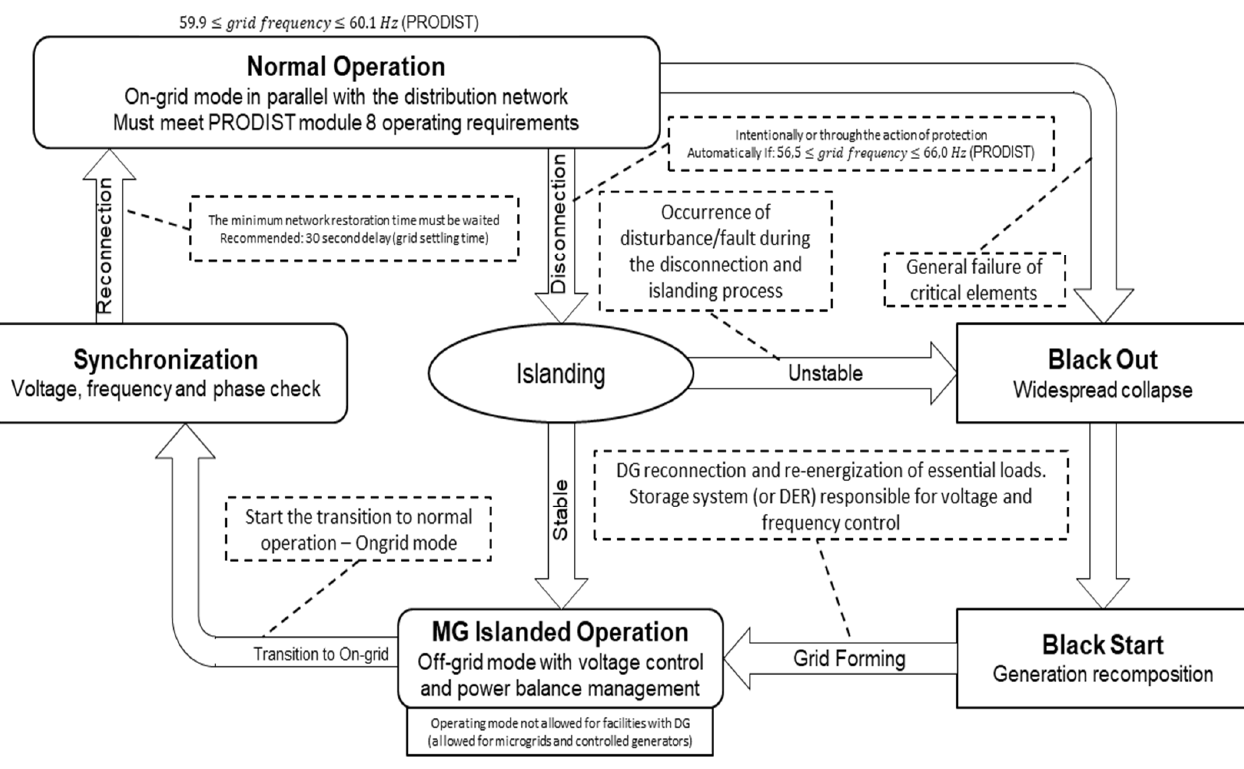
Figure 7. Operating modes allowed in operating procedures for microgrids—considering the PRODIST requirements.